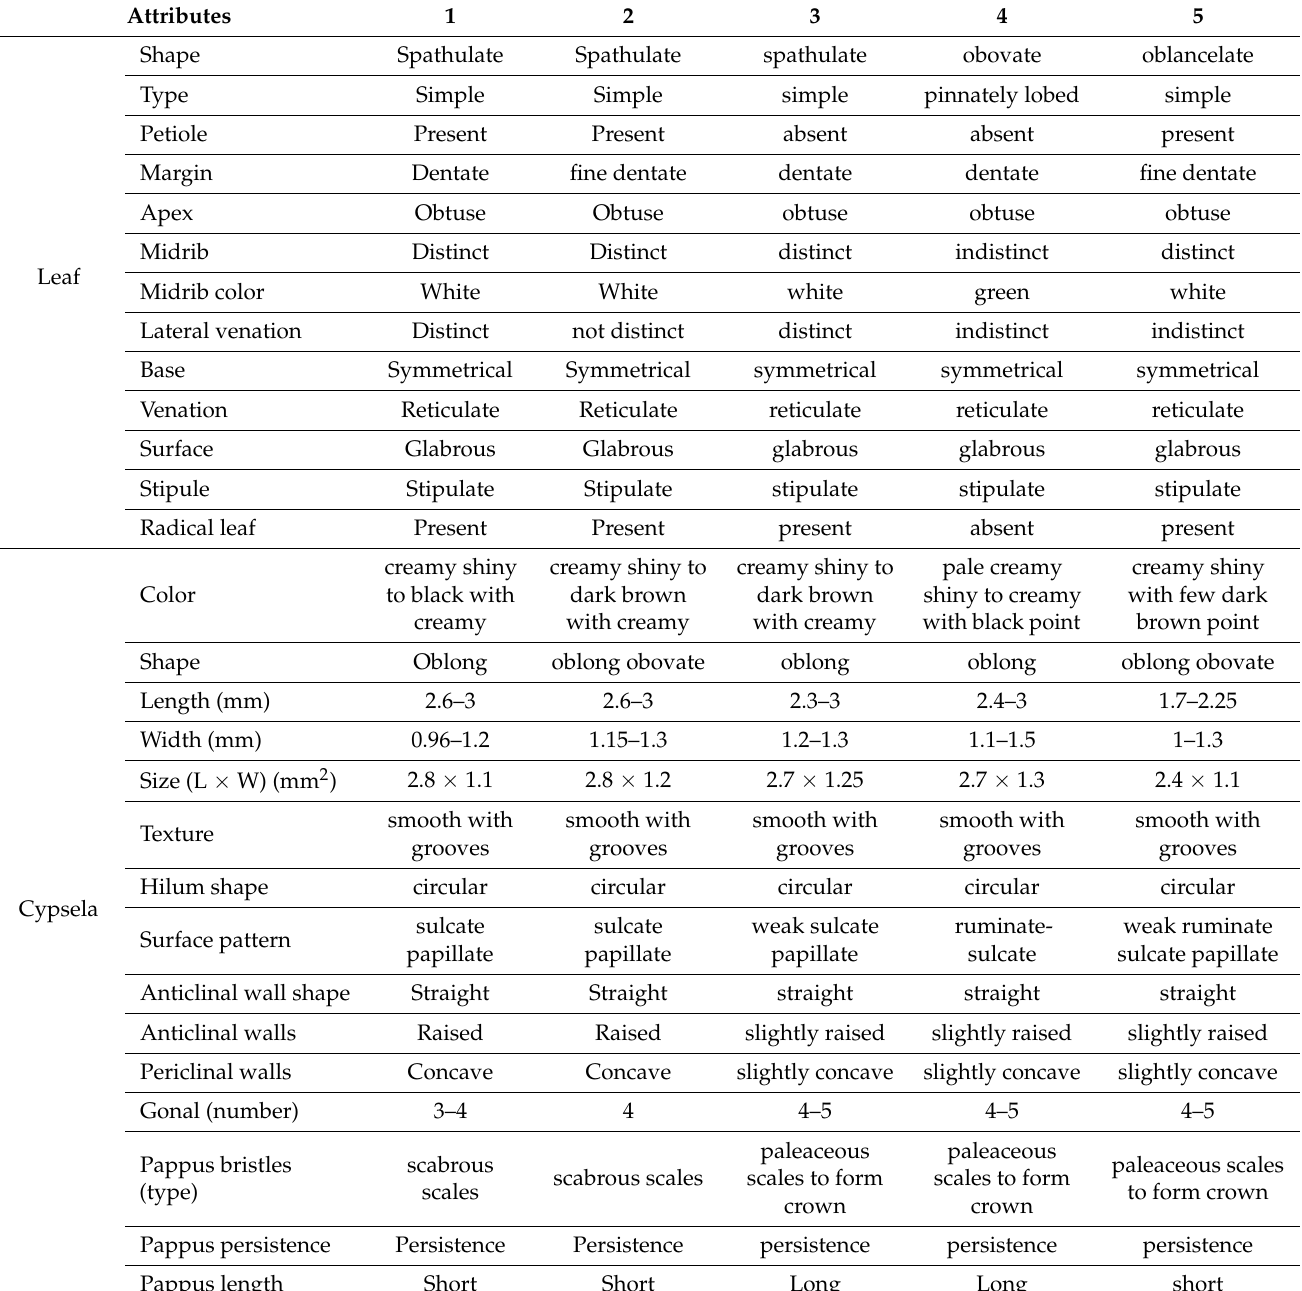
Table 1. Morphological characters of leaf and cypsela of Cichorium